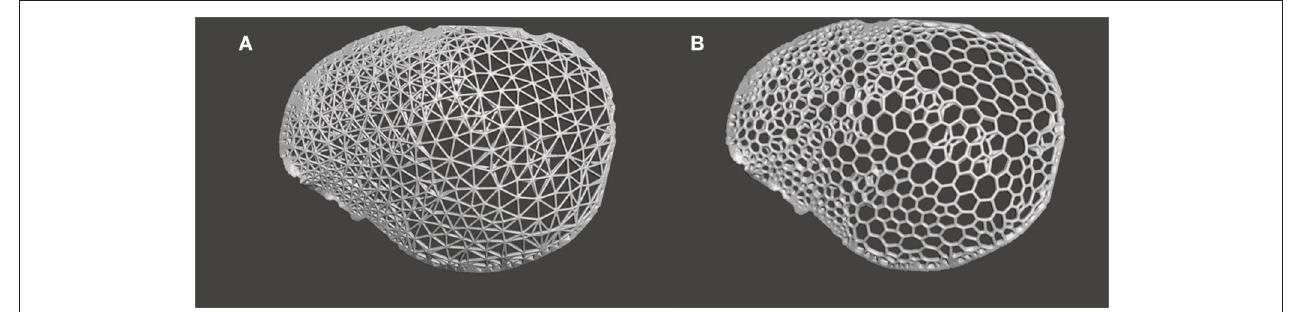
FIGURE 3 | Generative design modeling phase for the generation of a biomimetic patient-specific cranial prosthesis. (A) Wireframe/lattice Voronoi prosthesis design generated using the “Mesh + Delaunay Edges” algorithm. (B) Organic Voronoi prosthesis design developed using the “Mesh + Delaunay Dual Edges” algorithm.